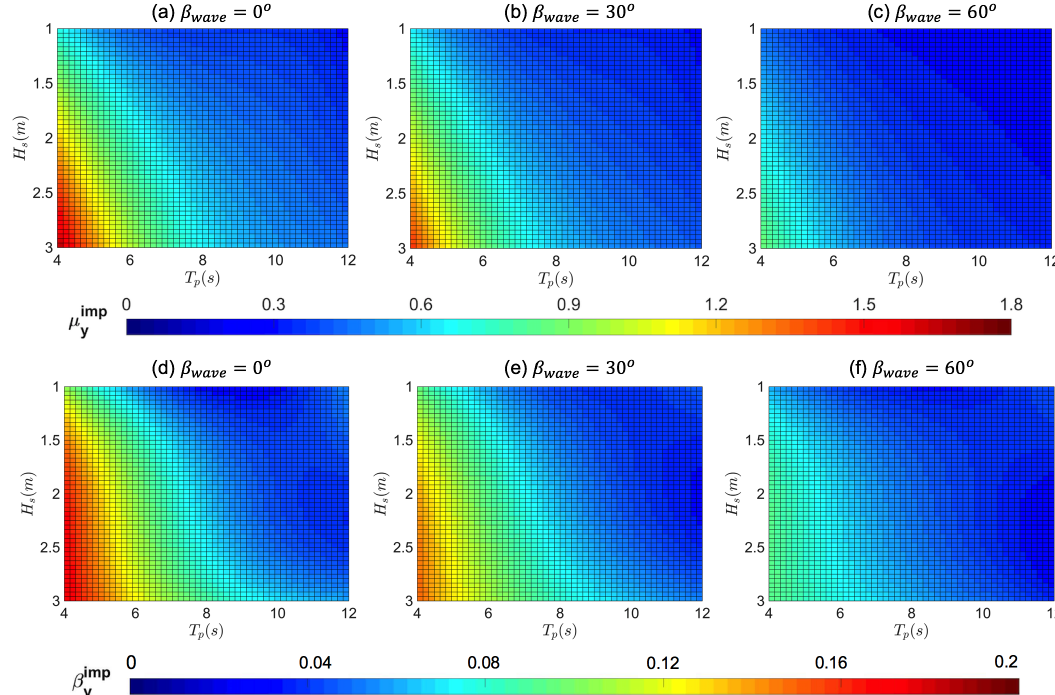
Figure 13. 2D-response surface contour plot for Gumbel parameters ( µ imp y , β imp y ) for load case H s = 2 m, T p = 4 s, U w = 6 m/s: µ imp y : ( a ) β wave = 0°( b ) β wave = 30°( c ) β wave = 60°; β imp y : ( d ) β wave = 0°; ( e ) β wave = 30°; ( f ) β wave =